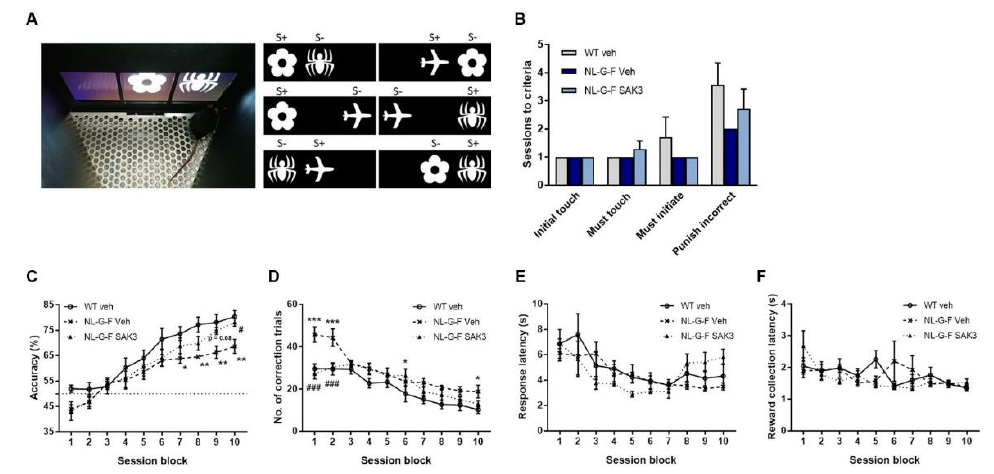
Figure 7. SAK3 administration improves upon the poor performance on the dPAL task in NL-G-F mice. ( A ) Photograph of a mouse performing the dPAL task in the screen operant chamber system and depictions of the six trial types used in the task. ( B ) The number of sessions required to reach the criterion during the pretraining phase ( n = 7 per group). ( C ) Accuracy, ( D ) number of correction trials, ( E ) response latency, and ( F ) reward collection latency in the dPAL task ( n = 7 per group). Each session block represents five testing sessions. Error bars represent SEM. * p < 0.05, ** p < 0.01, *** p < 0.001 vs. vehicle-treated WT mice; # p < 0.05, ### p < 0.001 vs. vehicle-treated NL-G-F mice.